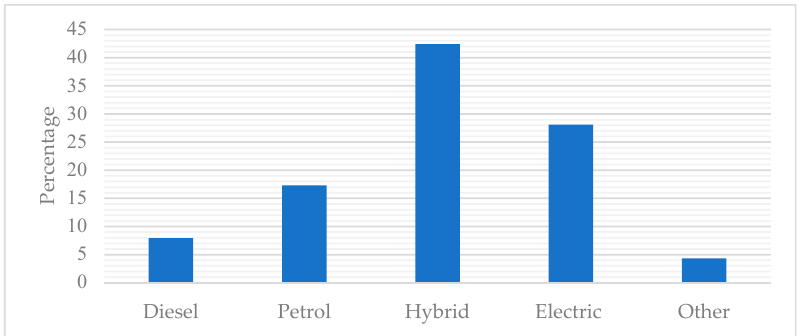
Figure 3. Which kind of vehicle to purchase in the future.